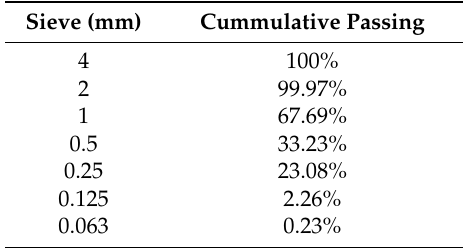
Table 2. Particle size distribution of the aggregate